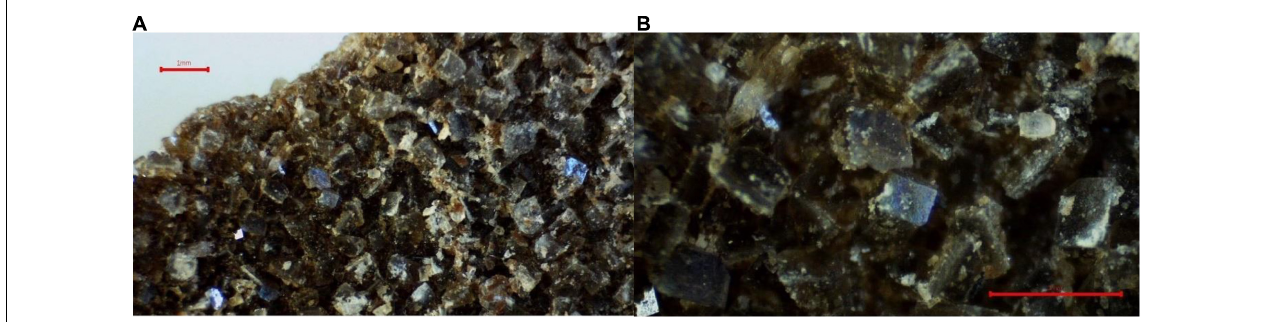
FIGURE 10 | Photographs of scanning electron microscopy (FEI-Quanta 200) under vacuum conditions and EDS system. Struvite crystals in (A) a millimeter scale and calcium precipitates in (B) a micrometer